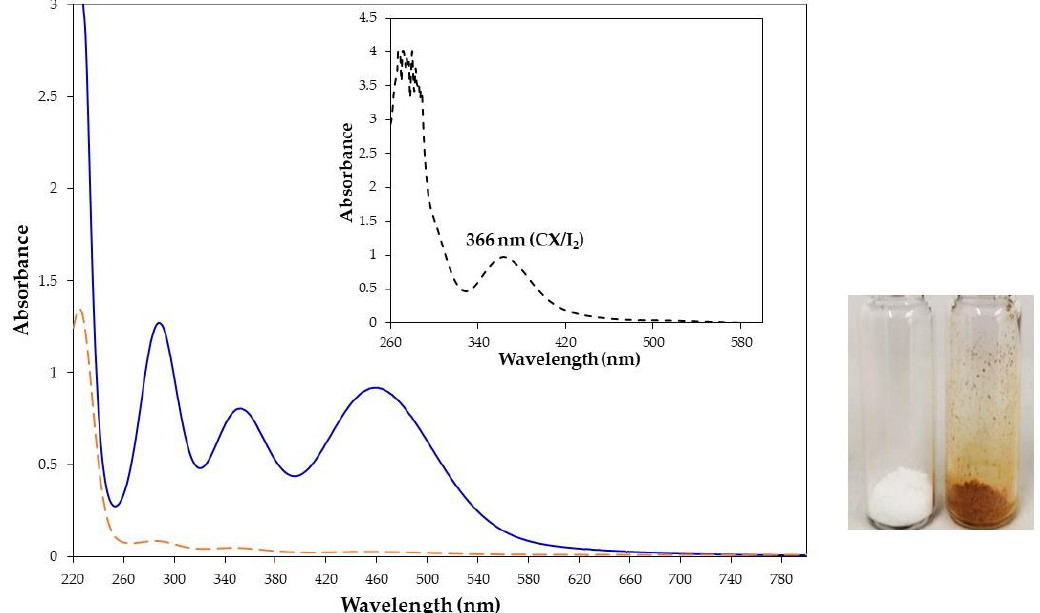
Figure 3. UV-vis spectra of iodine water solution (0.33 mg/mL, 1.3 × 10 −3 M) before (solid blue line) and after stirring with CX (dashed orange line) and CX/iodine complex powder dissolved in chloroform (inset). Pictures of CX (white powder) and its complex with iodine after filtration (orange powder).